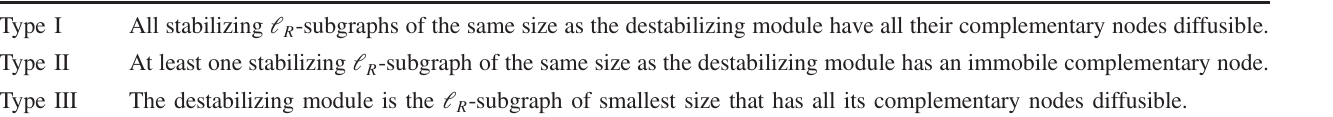
TABLE I. Topological features of Turing networks. Type I Type II Type III